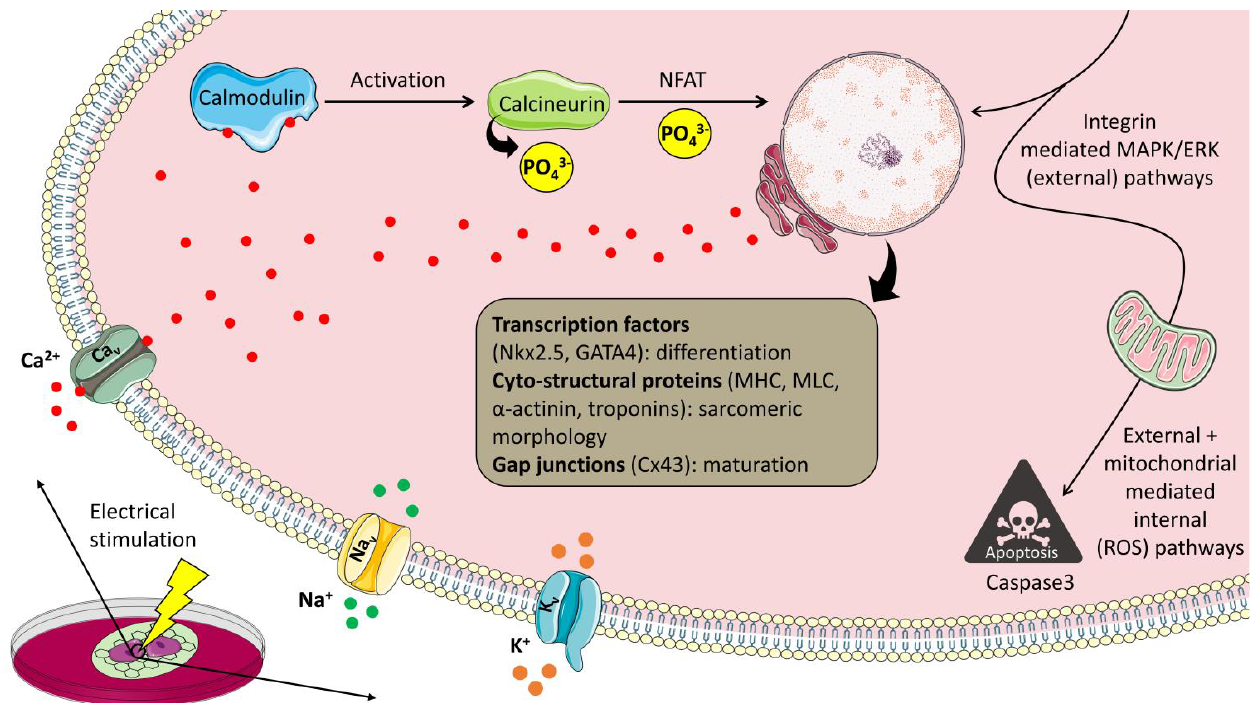
Figure 7. A scheme of cardiac stem cells cultured on a graphene-based conductive construct. This construct can trigger intracellular signalling pathways particularly when electrically stimulated. Such pathways can lead to the expression of cardiac specific genes that are an indication of the cardiac-like phenotype of the cultured cells. Sometime harmful external pathways (contamination of the culture medium due to high concentration of cell metabolic waste, extreme stiffness of the scaffold and toxicity of CNMs etc.) along with internal mitochondrial pathways (reactive oxygen species) can result in cell death via apoptosis by activating caspase